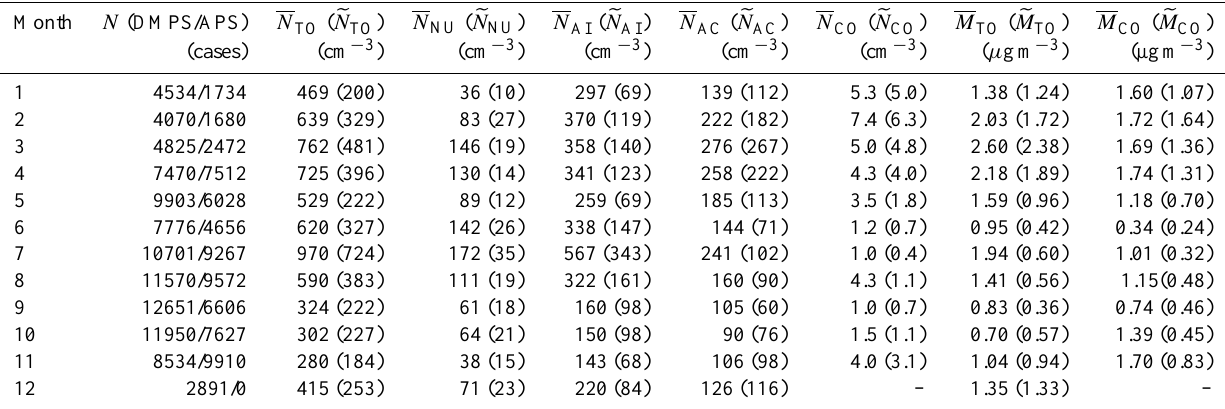
Figure 3. Temporal variability in aerosol total (7–500nm), nucleation mode (7–25nm), Aitken mode (25–100nm), accumulation mode (100–500nm), and coarse-mode ( > 410nm) number concentration, from top to bottom, respectively. Red bars show quartiles for each month of data available, and whiskers show the extremes. Black bars are calculated equally but excluding data measured when wind speed was < 2ms − 1 . Dotted black lines mark the boundary between years. Table 1. Average and median number and mass concentrations for different months. The first column indicates the month and the second column ( N ) the amount of data used in averaging for DMPS and APS instruments. The columns that follow present monthly average ( N TO , N NU , N AI , N AC , N CO , M TO , M CO ) and median ( e N TO , e N NU , e N AI , e N AC , e N CO , e M TO , e M CO ) values calculated for the total (7–500nm), nucleation mode (7–25nm), Aitken mode (25–100nm), accumulation mode (100–500nm), and coarse-mode ( > 410nm) number and for DMPS and APS total